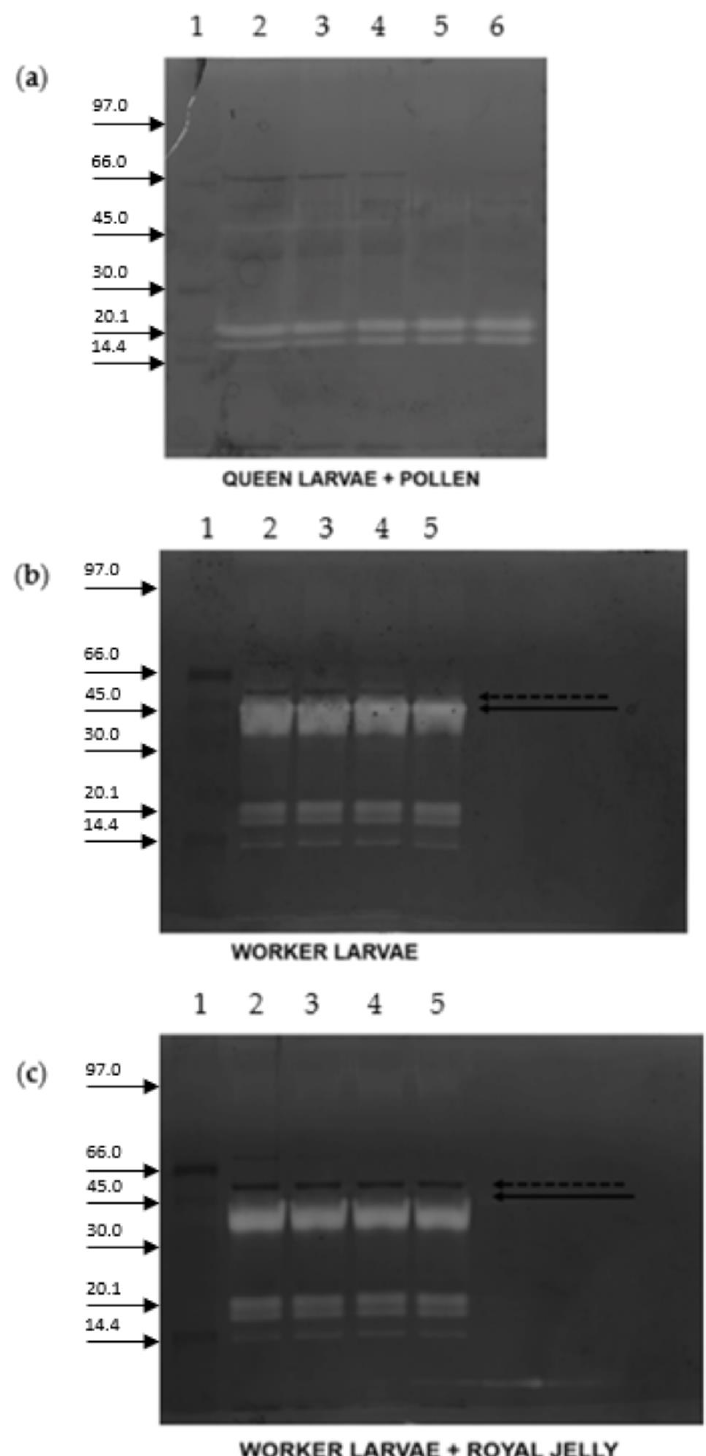
Figure 5. Zymography of the queen-fate larvae protein extracts (10% T, 2.6% C), marker low range. ( a ) Lane 1, marker low range in kDa; lane 2, queen-fate larvae protein extract; lanes 3 – 6, queen-fate larvae protein extract incubated with pollen crude extract at different times (0, 2, 12, and 24 h). ( b , c ) Lane 1, marker low range; lane 2 – 5, zymography of the worker-fate larva protein extracts incubated without ( b ) or with royal jelly crude extract ( c ) at different times (0, 30, 60, and 120 min). ( b , c ) The dotted arrow on the gel indicates the protease named PS4, the solid arrow indicates a new protease.